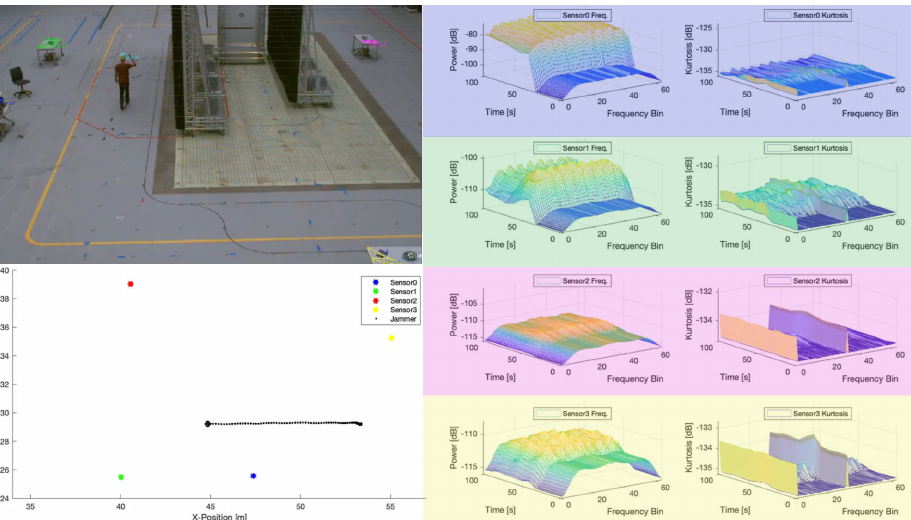
Figure 14. Exemplary GUI of the visualization component. Each sensor node is identified with a color (green, blue, pink, and yellow) in the photo in the top left, mapped to the ground plot in the bottom left, and the applicable data highlighted in the graphs in the